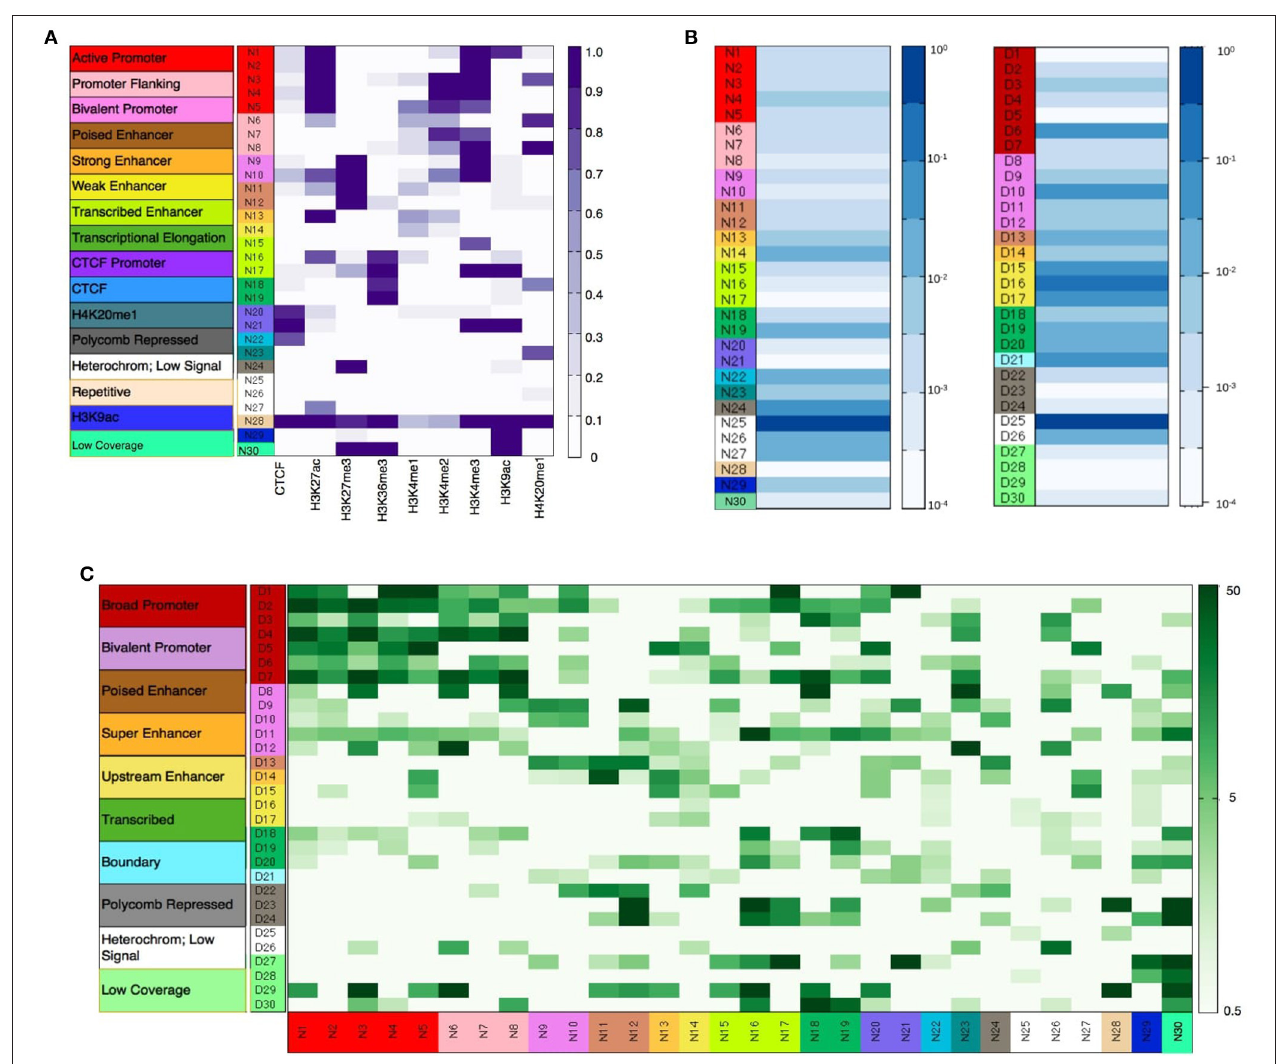
FIGURE 2 | (A) Nucleosome level emission matrix generated by diHMM. Functional annotations of the nucleosome level states are shown in the color bar on the left. Scale varies linearly between 0 and 1. (B) Fractional genome coverage for nucleosome and domain level states. Scale varies logarithmically between 10 − 4 and 1. (C) Combined nucleosome-domain fold change obtained by diHMM. Functional annotation of the states are shown in the color bar on the left. Scale varies logarithmically between 0.5 and